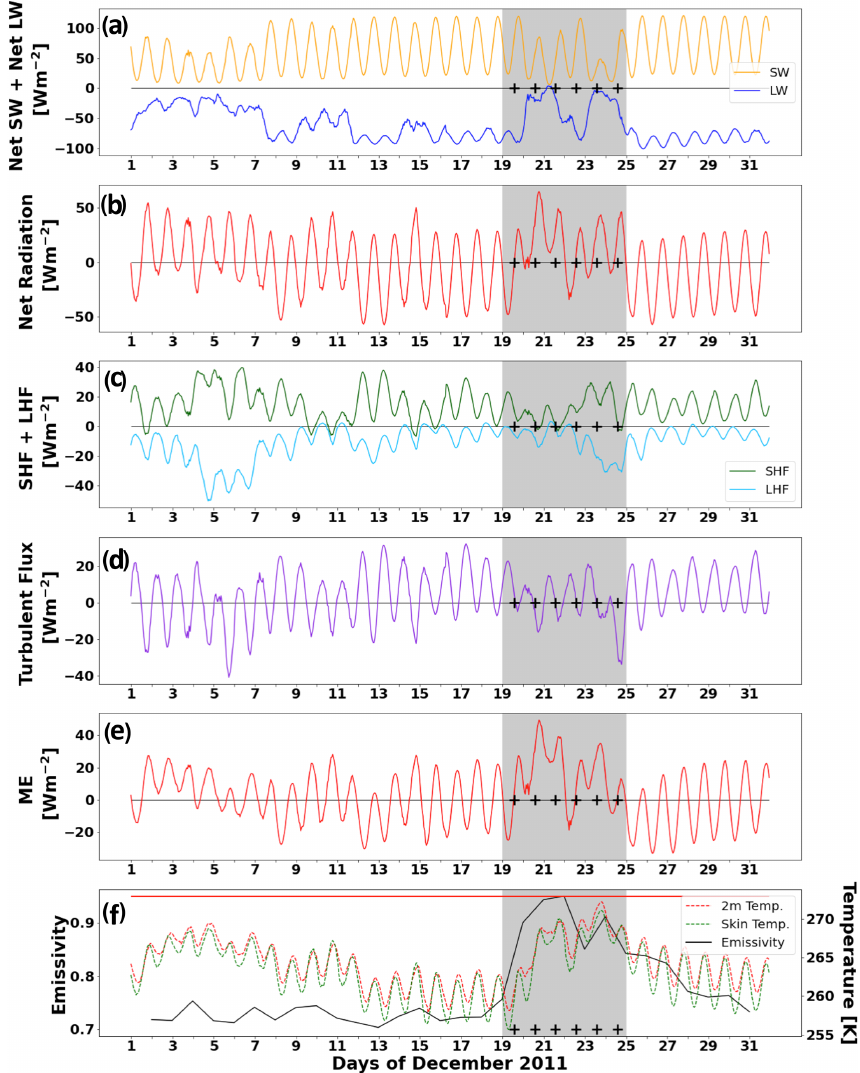
Figure 18. As in Fig. 4 but over the Pine Island and Thwaites Glacier region throughout December